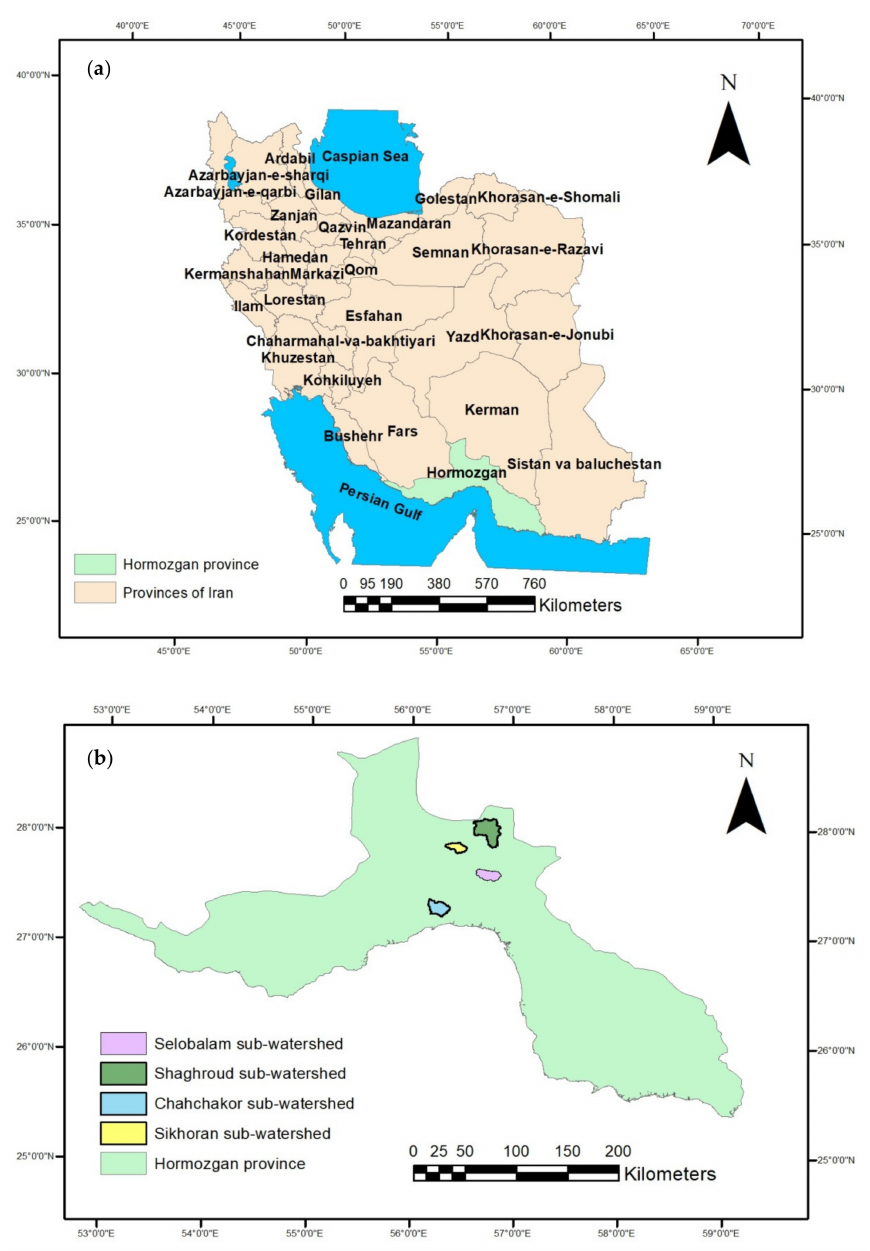
Figure 3. ( a ) Location of Hormozgan province in Iran. ( b ) Location of sub-watersheds in Hormoz- gan